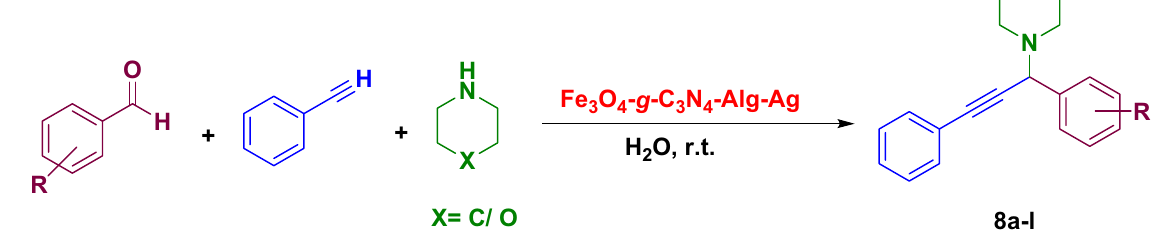
Figure 3. A3 and KA2 coupling reactions.